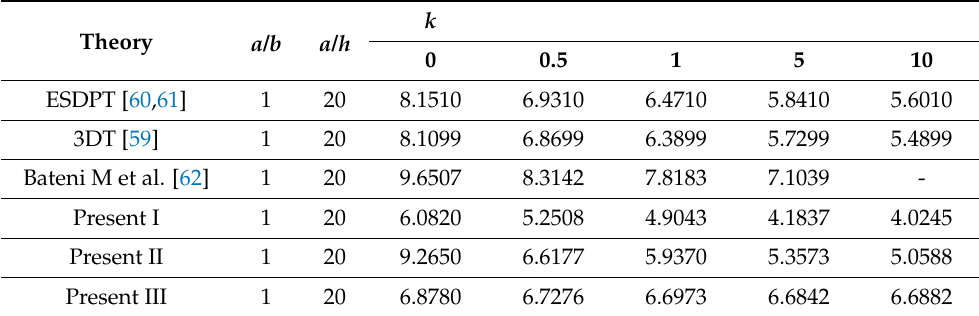
Table 3. Critical buckling load Pcr for the FGM plates subjected to uniaxial compressive loads in the x